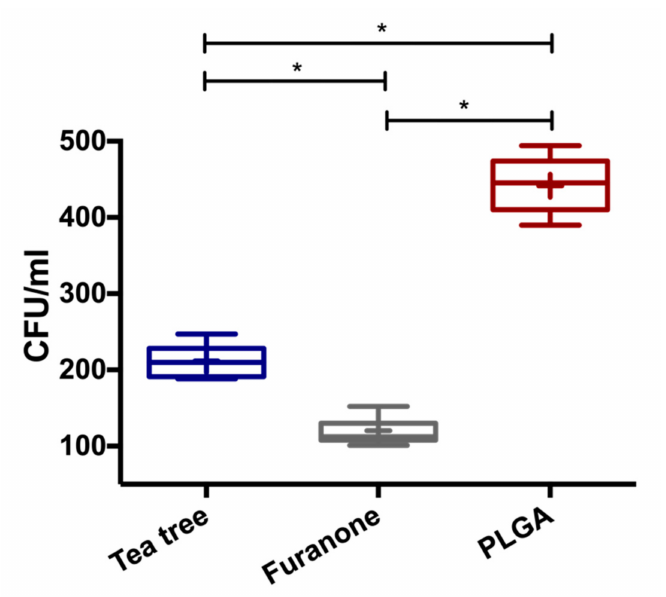
Figure 5. S . mutans biofilm formation (TSB, 48 h at 37 ◦ C) over electrospun membrane surfaces, measured by colony forming units (CFU/mL). * ANOVA and Tukey’s post-hoc with a significance level of p <